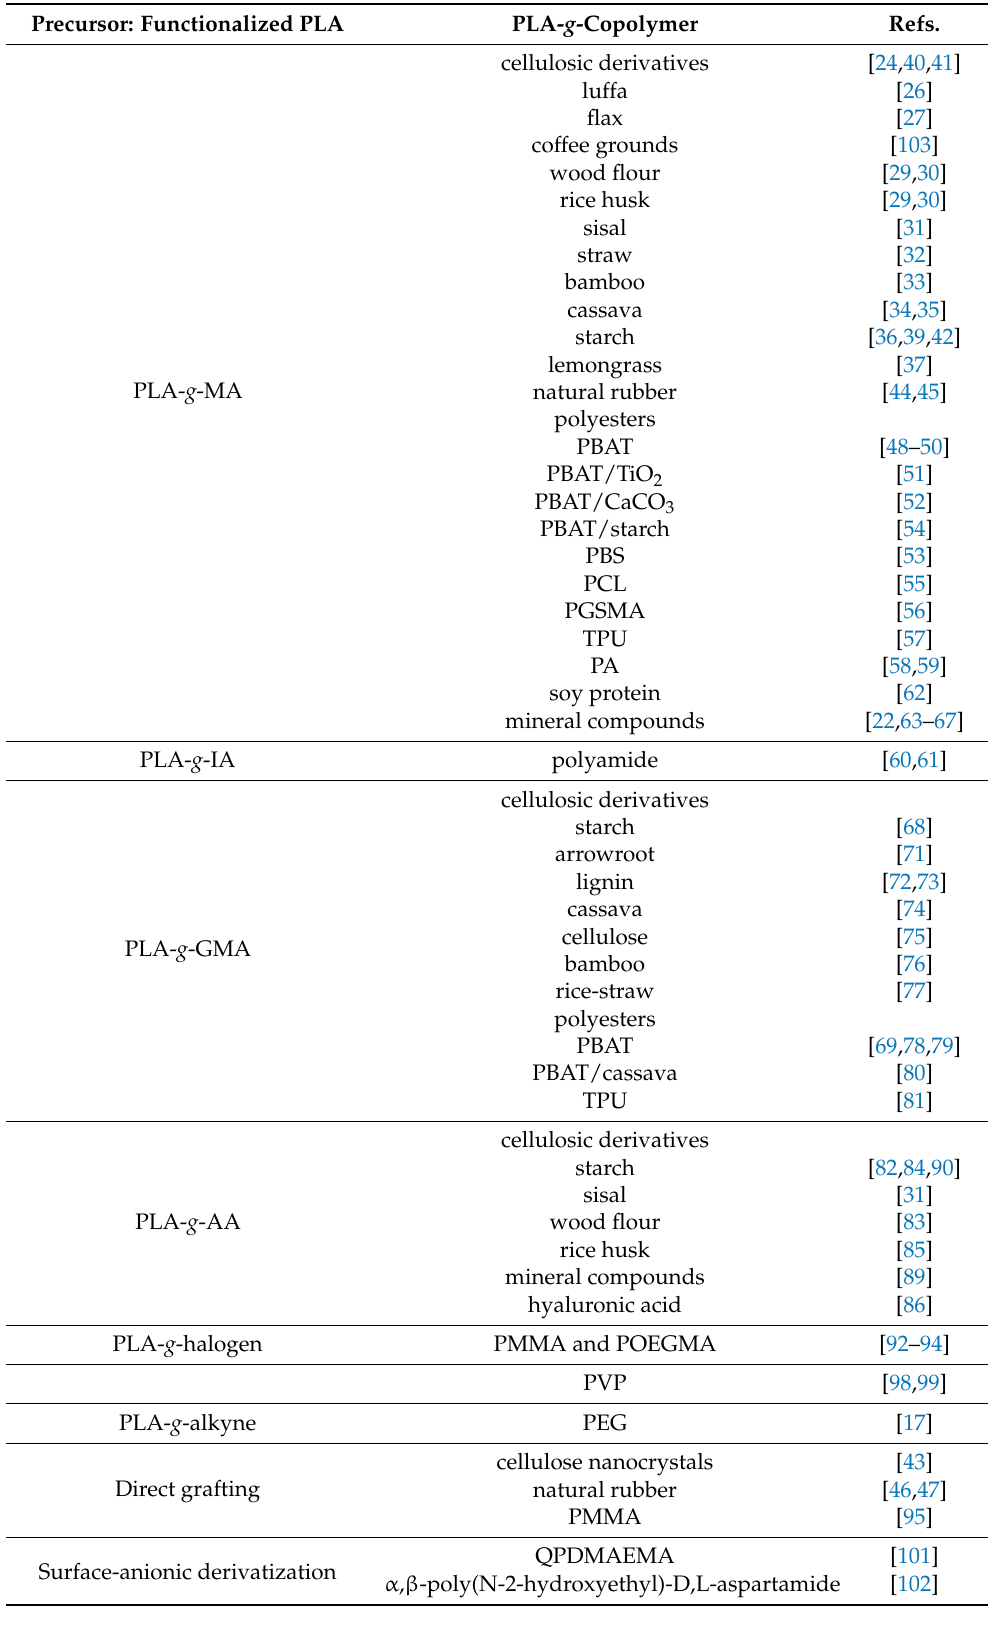
Table 3. Main PLA-based grafted copolymers according to